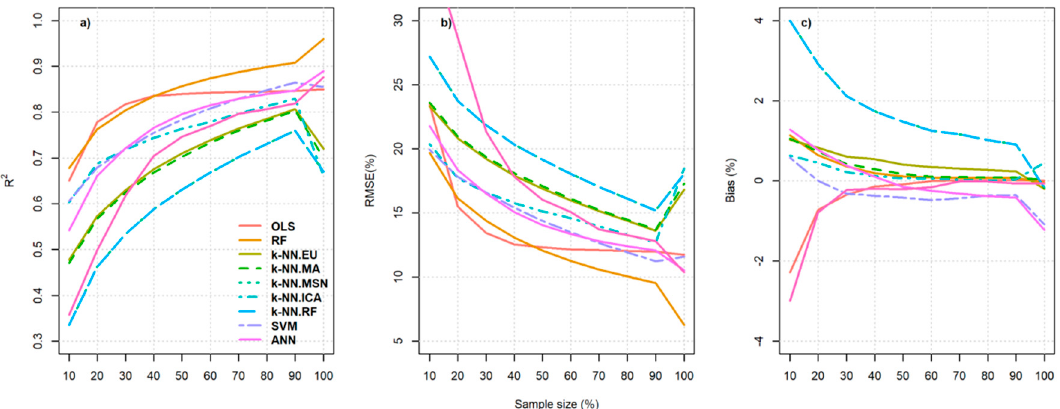
Figure 6. Modeling methods’ performance in terms of ( a ) coe ffi cient of determination (R 2 ), ( b ) relative root mean square error (RMSE%), and ( c ) relative bias derived from the 500 bootstrapping simulations for each sample size.